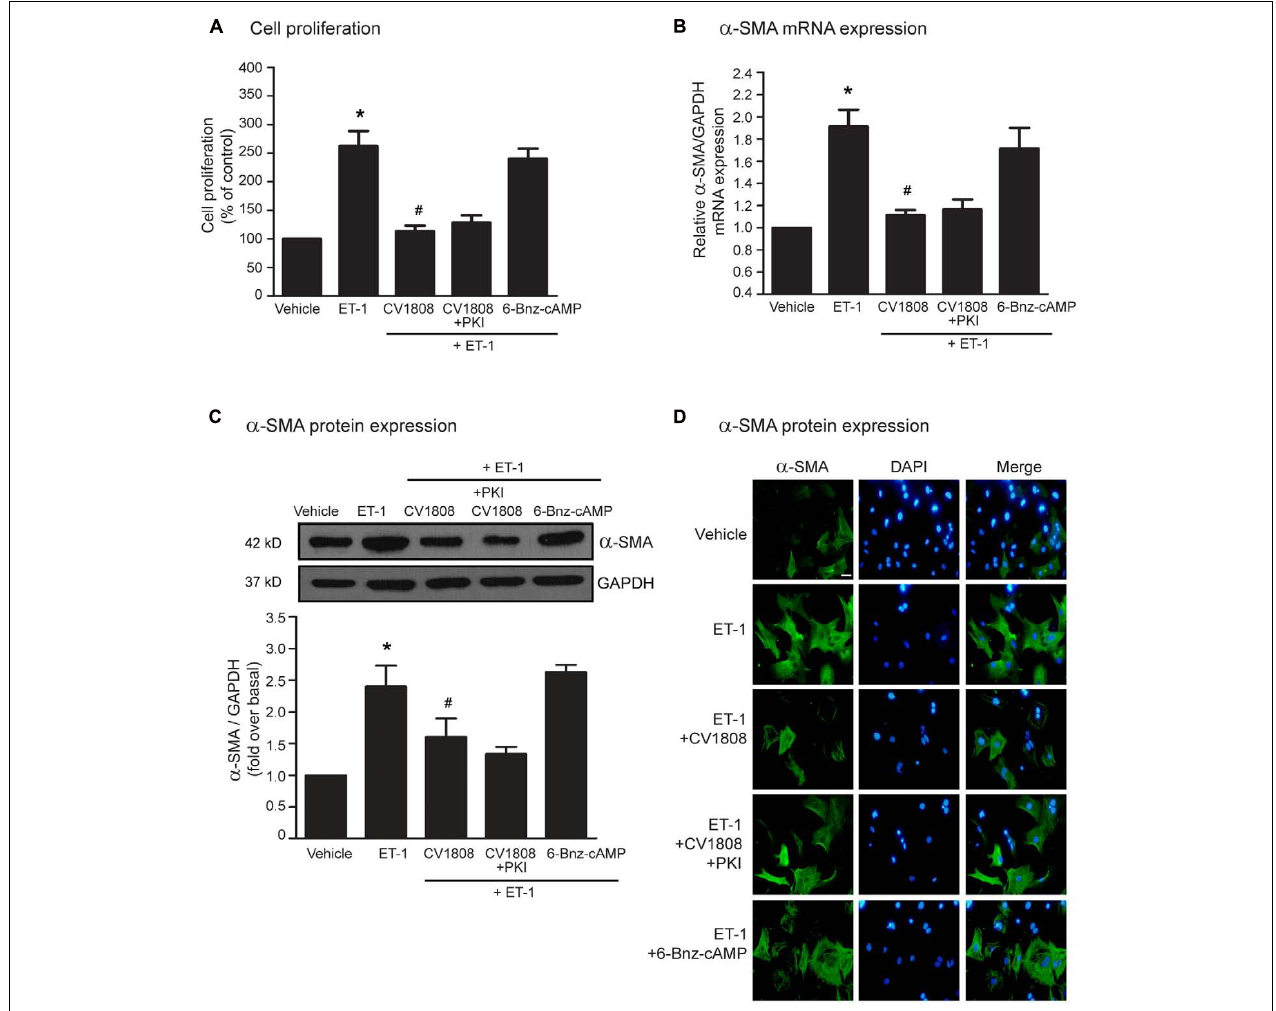
FIGURE 3 | CV1808 mediated-inhibition of ET-1-induced cell proliferation and α -SMA synthesis is independent of PKA. (A–D) Cardiac fibroblasts were pretreated without or with 10 µ M PKI (PKA inhibitor) for 1 h. After 1 h, cells were treated with vehicle (control), 1 µ M 6-Benz-cAMP (PKA activator), or 10 µ M CV1808 for 1 h and further stimulated with 20 nM ET-1 for 12 h (B) or 24 h (A,C,D) at 37 ◦ C. (A) Cell proliferation was quantified by MTT assay. The data were expressed as the percentage relative to the non-treated group, and shown as mean ± SEM ( n = 4). ∗ P < 0.05 vs. vehicle; # P < 0.05 vs. ET-1. (B,C) Relative α -SMA mRNA (B) and protein (C) levels were quantified and shown as the mean ± SEM ( n = 4). ∗ P < 0.05 vs. vehicle; # P < 0.05 vs. ET-1. (D) Cells were incubated with anti- α -SMA antibody followed by goat anti-mouse antibody (Alexa Fluor 488). The α -SMA was visualized by fluorescent microscope. Cells were stained for α -SMA (green) and nuclear staining of nucleus with DAPI (blue). Bar, 10 µ